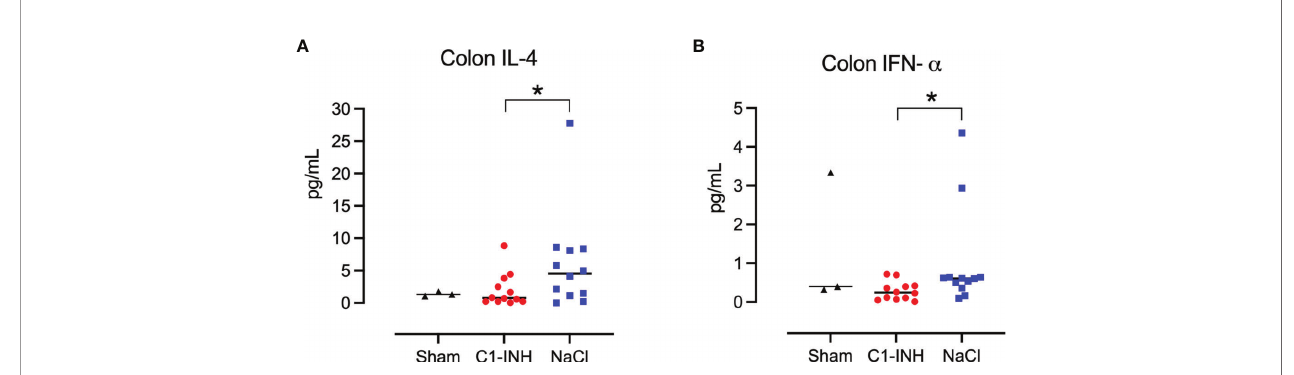
FIGURE 9 | Cytokines in tissue. Post mortem biopsies from seven organs were homogenised and analysed for cytokines by multiplex immunoassays. C1-INH- treatment had no effect on the tissue cytokines except for two cytokines in the colon tissue: (A) interleukin (IL)-4 and (B) interferon (IFN)- a . Asterisks mean p=0.022 and